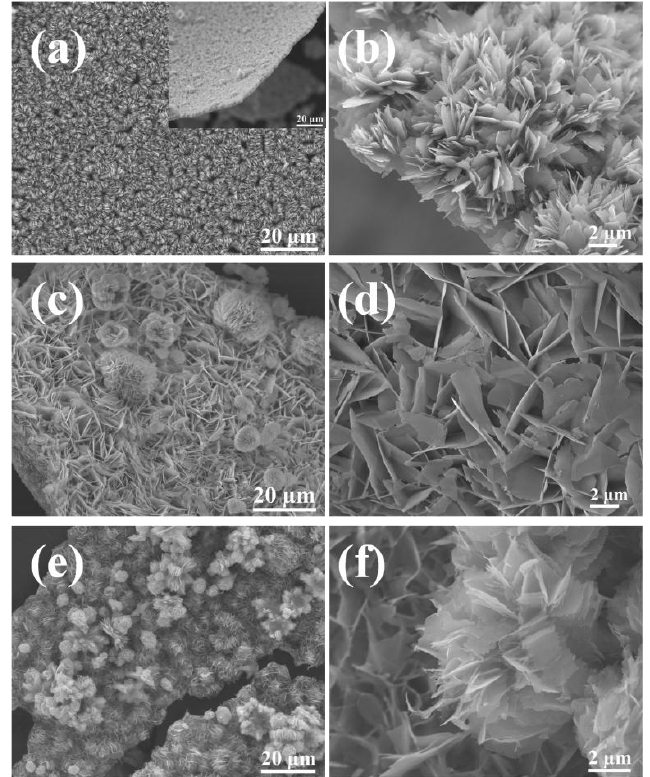
Figure 3. SEM images of ZnO samples F5–F7 prepared with different urea/Zn 2+ molar ratio R: ( a , b ) R = 1; ( c , d ) R = 5 and ( e , f ) R =